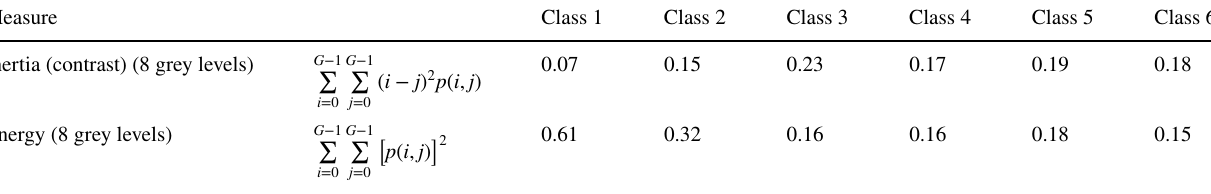
Table 5 Second order statistics for combined subblocks from each class. Results were calculated by considering each 2D slice in the subblock volume in two orientations and were required using 8 grey levels Measure Class 1 Inertia (contrast) (8 grey